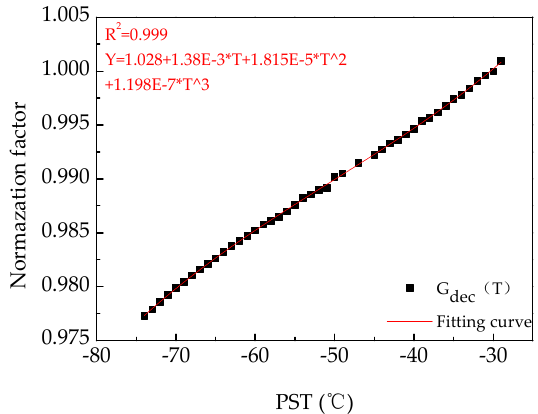
Figure 15. Experimental results of G det (T). This detector ‐ level experiment determined that the re ‐ sponsivity was reduced by approximately 1.5% when the PSAC operated on orbit (T ≈− 65 °C) com ‐ pared with the laboratory ‐ based radiometric test (T ≈ − 30 °C), with around 35 °C PST difference. The error sources of detector ‐ level experiments were analyzed to determine their im ‐ pact on the measurement of G det (T) and F fil (t). The random errors include the instability of light source radiance, stray light in the laboratory, common frequency interference and noise, temperature instability of detector photosensitive surface and filter, and nonlinear ‐ ity and instability of detector radiation response. The stability of the integrating sphere radiance was greater than 2‰/h. The results of the detector ‐ level bench stability experi ‐ ment have shown that temperature fluctuation and common frequency interference are effectively suppressed. The response linearity of the detector is about 100% according to the report provided by the manufacturer. Similar to the instrument ‐ level test, the chopper may cause system error in the detector ‐ level test, and its influence is also limited. With multiple measurements and normalizing fitting, the influence of these errors on G det (T) and F fil (t) measurement is further limited, ensuring the accuracy of the detector ‐ level ex ‐ periment. To further verify the effectiveness of the condition control measures and dark count subtraction methods used in the detector ‐ level experiment with large temperature ranges of the heat sink, the normalized results of the responsivity temperature dependence curves measured in two detector ‐ level sub ‐ experiments with different heat sink cooling conditions were compared. The comparison of the responsivity temperature dependence results is shown in Figure 16. The difference between the two sets of results was less than 0.05% after performing temperature correction on the filter transmittance. These results suggest that the condition control measures adopted in the detector ‐ level experiment were effective and reduced the influences of various factors on the experimental results. In par ‐ ticular, based on the dark reference provided by the chopper dark reference, the back ‐ ground radiation response at different heat sink temperatures was reduced. Thus, the ac ‐ curacy of the experimental results was improved and provided a good basis for obtaining